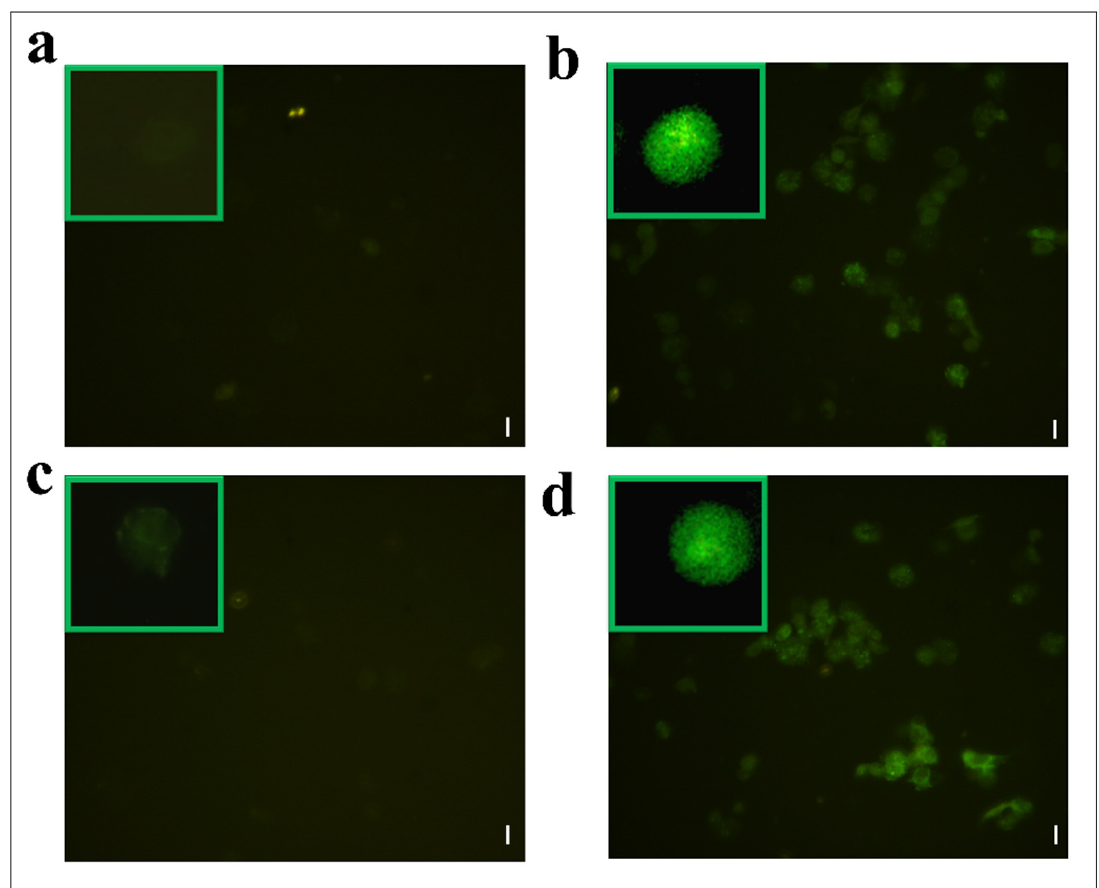
Figure 7. H 2 DCFDA staining of hemocytes treated with 1 X PBS (control) ( a ) or treated with OPs deriving from two equivalent females, ( b ) fraction #22 ( c ) and fraction #26 ( d ). Scale bar 10 µm. In green boxes, enlarged cells are reported.